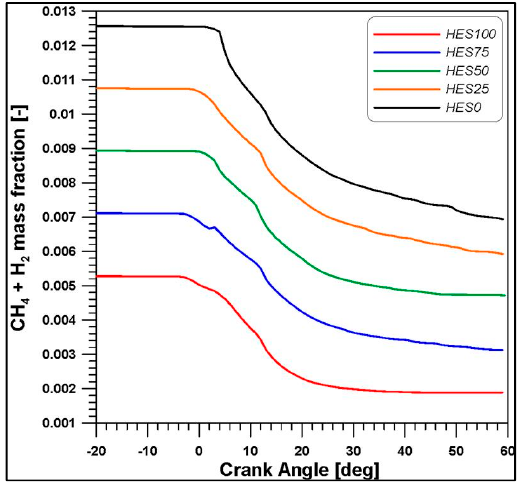
Figure 19. Fuel (H 2 + CH 4 ) mass fraction.